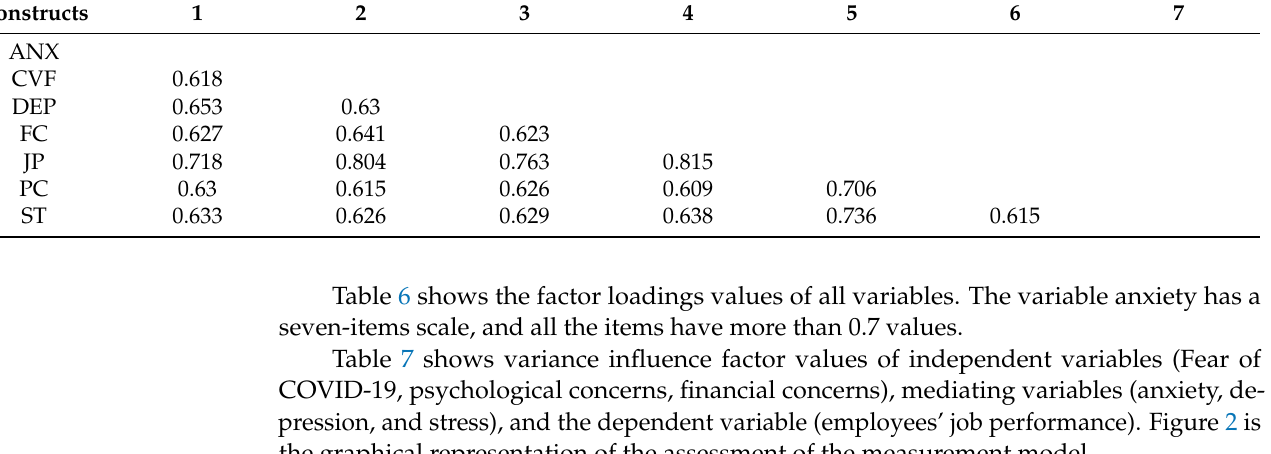
Table 5. Discriminant Validity Analysis (HTMT).